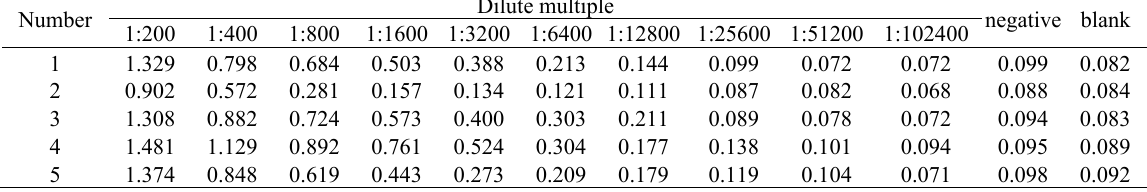
Determination of immunogen indirect ELISA results in pig serum blocking solution (OD450)